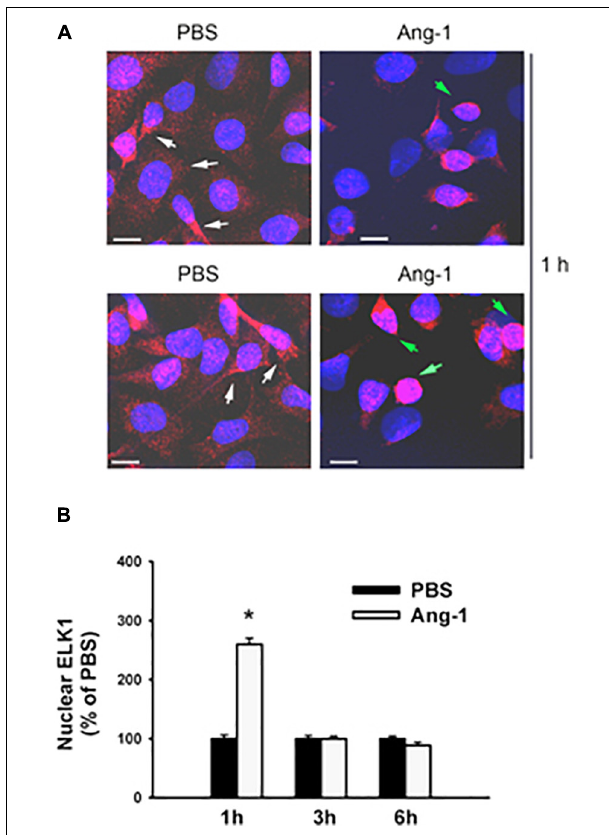
FIGURE 5 | Ang-1 increases nuclear localization of ELK1. (A) Representative immunofluorescence images of ELK1 protein (red color) and nuclear staining (DAPI, blue) in HUVECs exposed to PBS or Ang-1 for 1 h. Green arrows indicate cells with strong nuclear ELK1 staining; white arrows indicate cells with strong cytosolic ELK1 staining. (B) Fluorescence intensity of nuclear ELK1in HUVECs exposed to PBS or Ang-1 for 1, 3, or 6 h. Values are means ± SEM, expressed as percent of PBS. * P < 0.05, compared to PBS. N > 130 cells per group. White bars indicate 10 µ m.